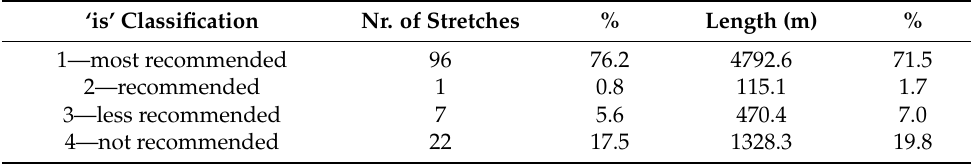
Table 14. The Index of Slopes and Stairs (is) applies to the study area. ‘is’ Classification Nr. of Stretches % Length (m) % 1—most